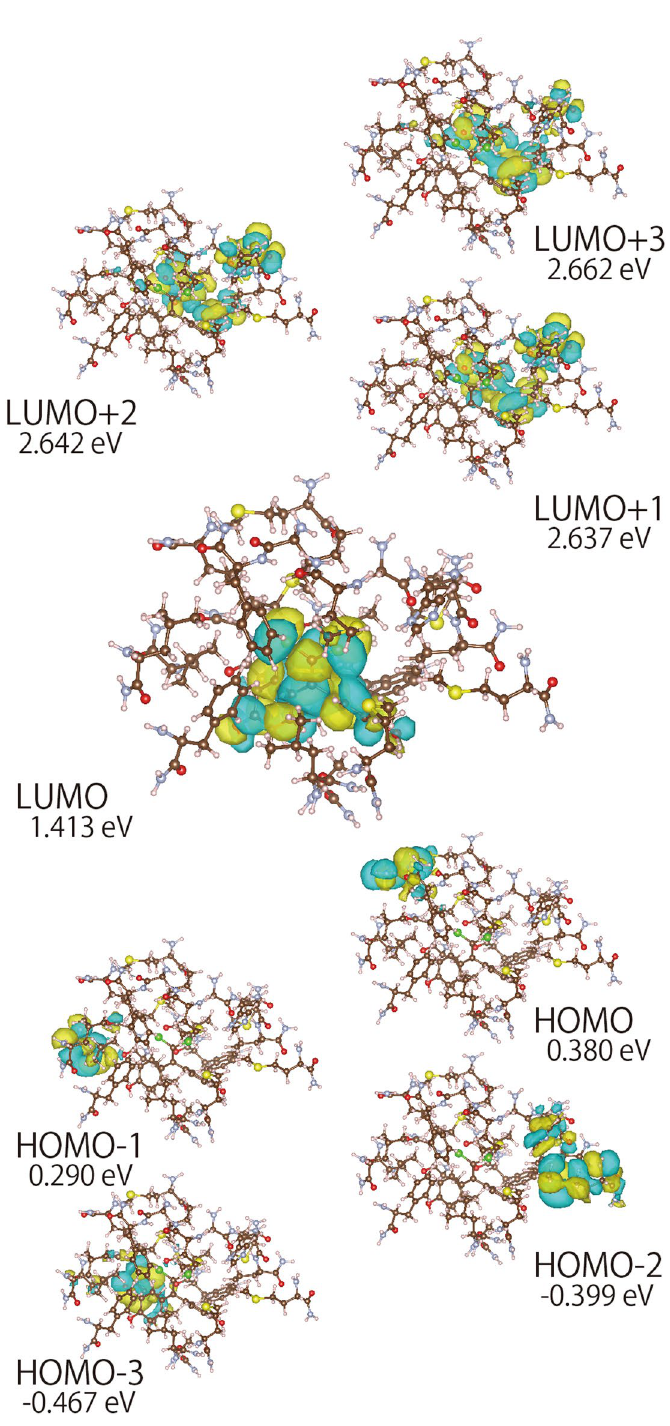
Figure 7. The HOMO and LUMO calculated using the coordinates clipped 7 Å from the chlorine atoms via the HIVE clip method. The calculated molecular orbitals are illustrated as electron clouds. The electron levels of each orbital are indicated under each figure. The LUMO was restricted in close proximity to the ligand in the ER α